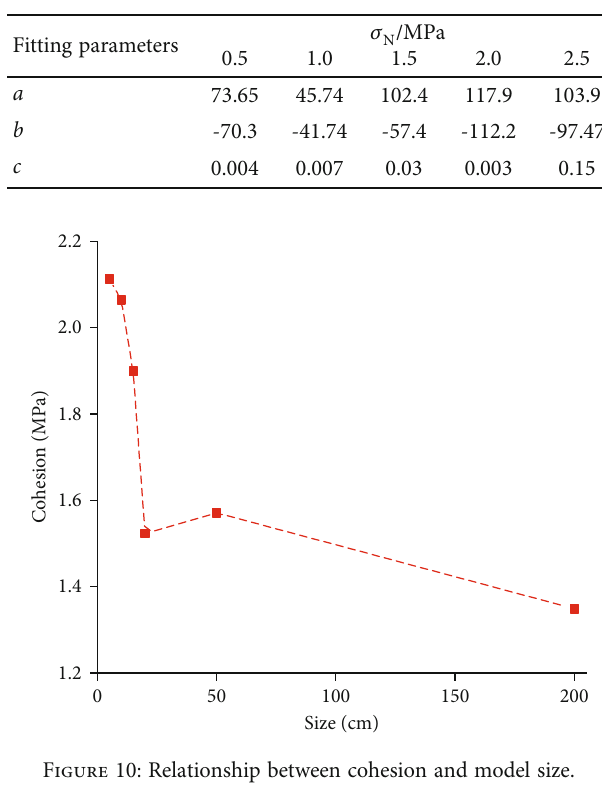
Table 5: Parameter fi tting results of power function